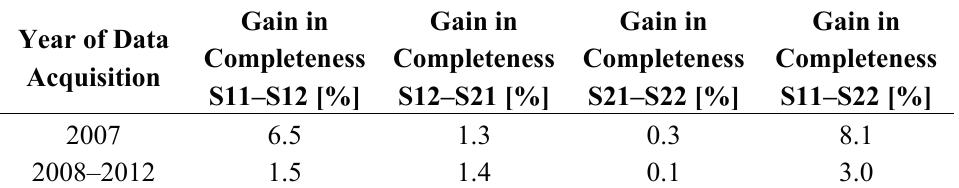
Table A3. Gain in completeness with the different strategies and image stripes used. Comparison of the year 2007 where a combination of Pan and RGB was used and the years 2008–2012 where matching was based on CIR images (S11: 1st nadir stripe/“ADS steep”, S12: 1st nadir stripe/“ADS flat”, S21: 2nd nadir stripe/“ADS steep”, S22: 2nd nadir stripe/“ADS flat”).